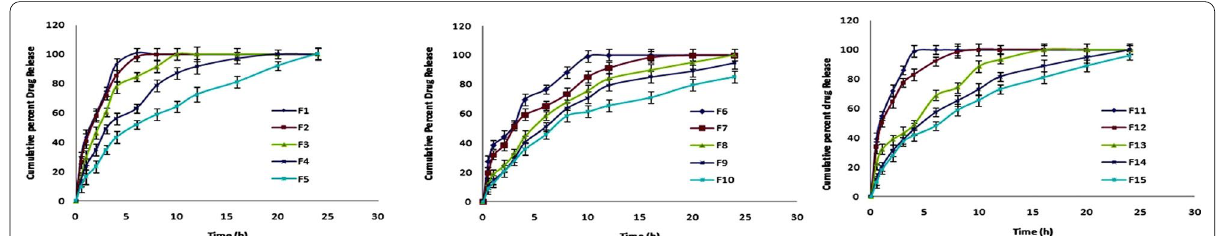
Fig. 6 Schematic diagram elucidating the in vitro dissolution studies of cefuroxime axetil mucoadhesive minitablets